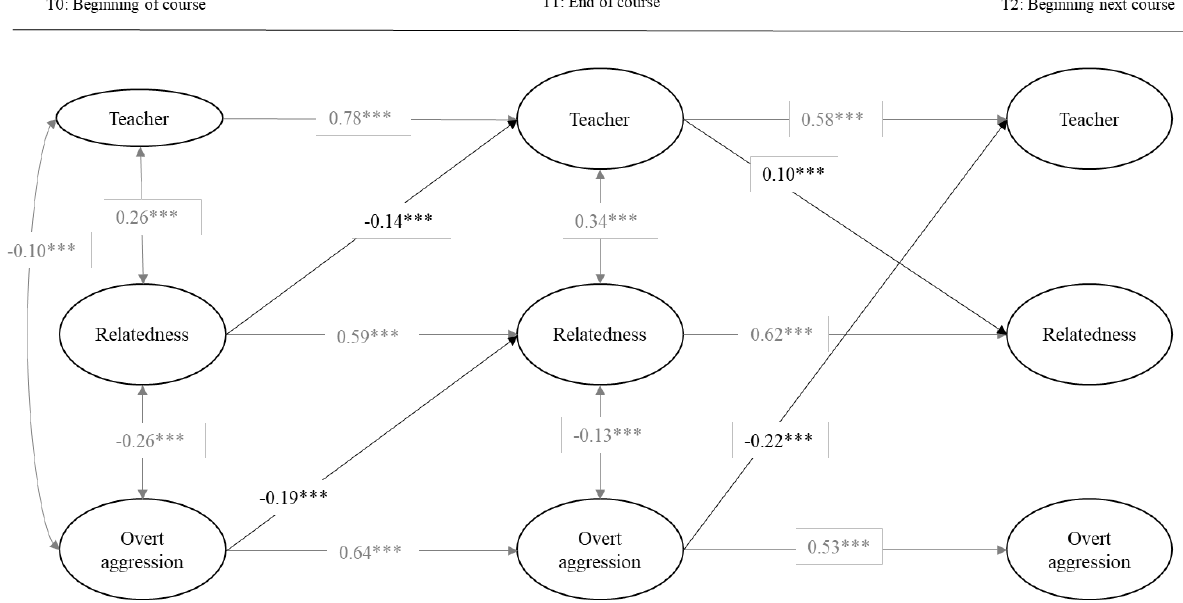
Figure 2. Cross-lagged model predicting longitudinal reciprocal relations between teacher support, relatedness, and overt aggression in boys. Only estimates significant at p < 0.05 or less are provided. Cross-lagged paths are depicted in bold. *** p < 0.001.